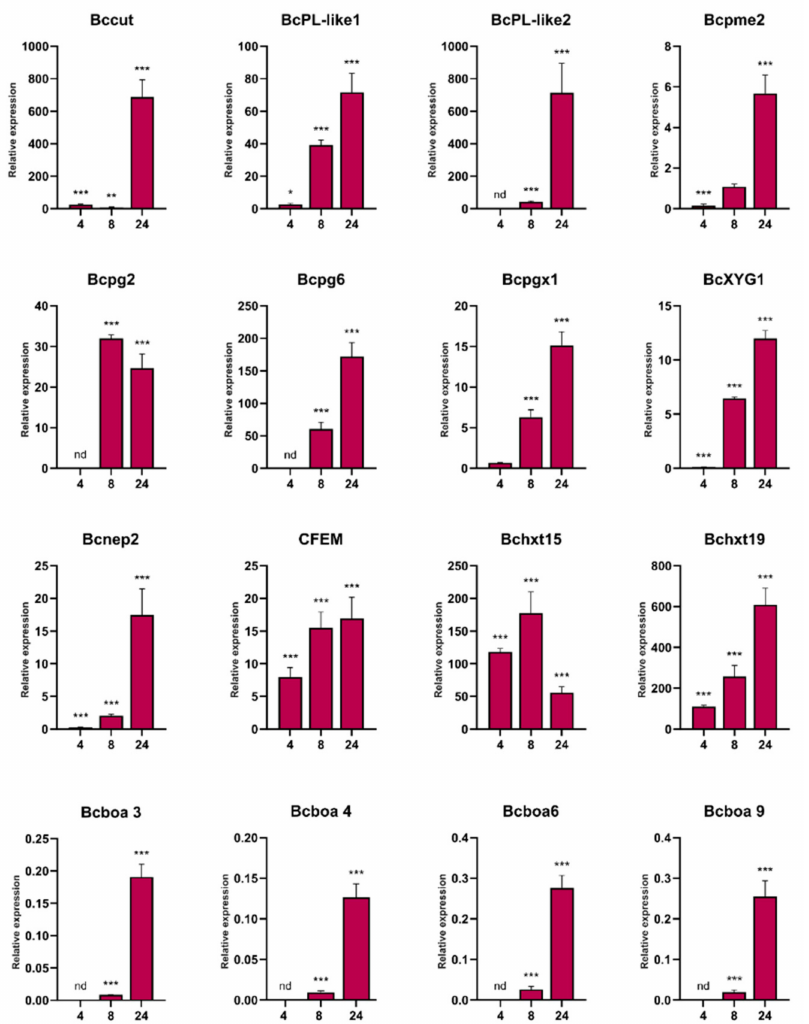
Figure 3. Validation of B. cinerea differentially expressed genes during P. patens infection by quantity reverse transcription RT-qPCR at 4, 8 and 24 hpi. The expression levels of B. cinerea genes infecting P. patens at the indicated time points are relative to the level of expression of B. cinerea grown in PDA. Genes are represented by the corresponding abbreviation as indicated in Table S1. BctubB was used as the reference gene. Results are reported as means ± standard deviation (SD) of three samples for each treatment. Asterisks indicate a statistically significant difference between B. cinerea grown in P. patens and in PDA (Students t -test, * p < 0.5, ** p <0.01; *** p < 0.005). Abbreviation: nd: no